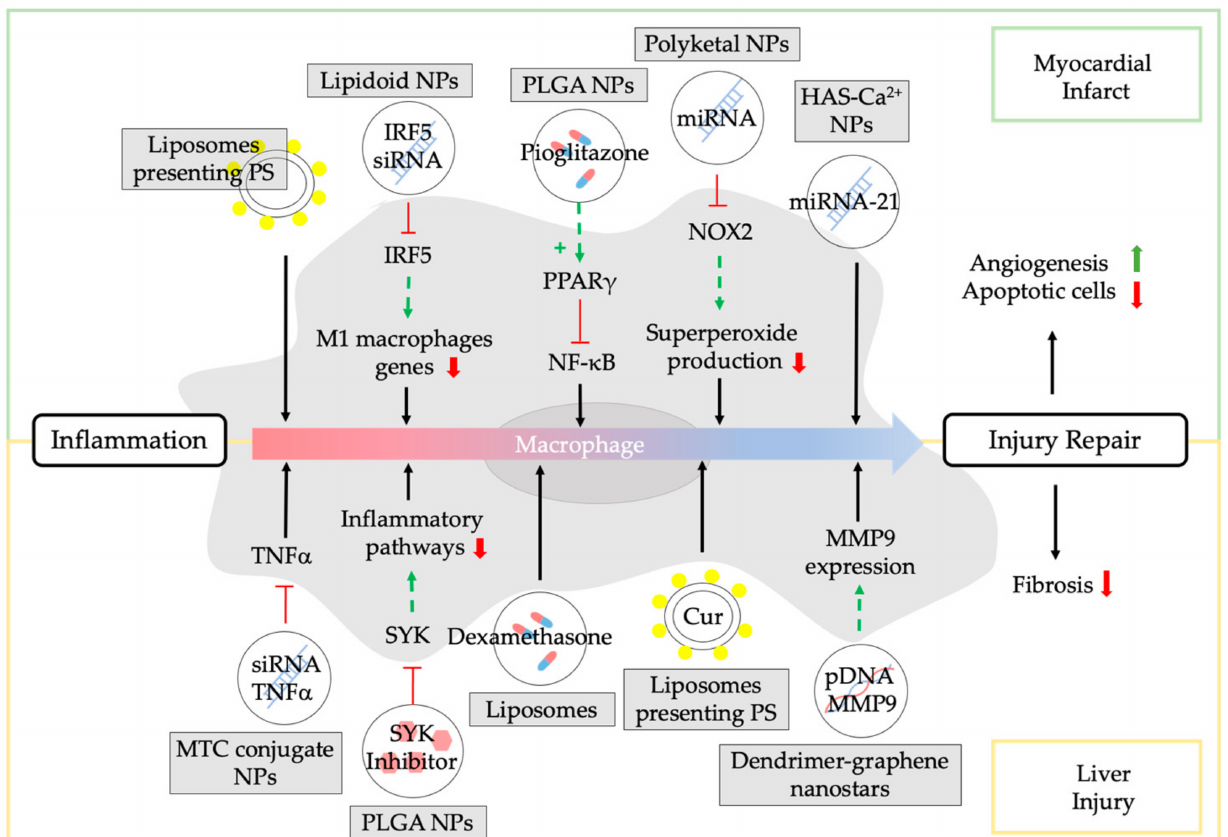
Figure 5. NPs to target and treat macrophages for tissue repair. The figure summarizes different therapeutic approaches to design NPs loaded with different biomolecules to stimulate tissue repair after liver injury (yellow rectangle) and myocardial infarct (green rectangle). All these therapies focus on reducing inflammation and/or inducing a pro-regenerative macrophage phenotype to promote repair. PS: phosphatidylserine; NPs: Nanoparticles; IRF5: interferon regulatory factor 5; SiRNA: small interference ribonucleic acid; PLGA: poly (lactic-co-glycolic acid); PPAR γ : peroxisome proliferator-activated receptor-gamma; NF- κ B: nuclear factor kappa light chain enhancer of activated B cells; Nox2: NADPH oxidase 2; HAS: hyaluronan-sulfate; TNF α : tumor necrosis factor alpha; MTC: mannose-modified trimethyl chitosan-cysteine; SYK: Spleen Tyrosine kinase; Cur: Curcumin; pDNA: plasmid DNA; MMP9: matrix metalloproteinase